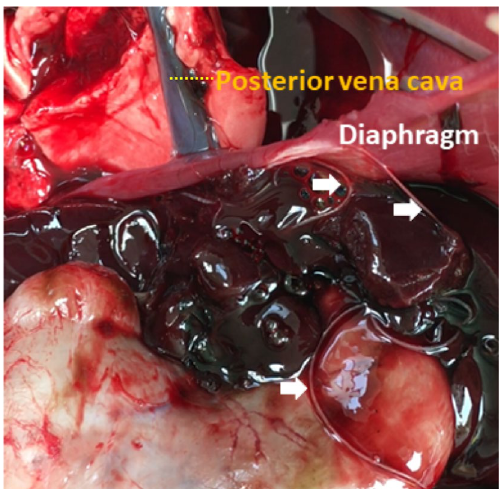
Figure 1. Necropsy from hare-1. Incision of posterior vena cava, in its passage through the diaphragm, exposed several specimens (black arrows) of parasites, still with mobility.